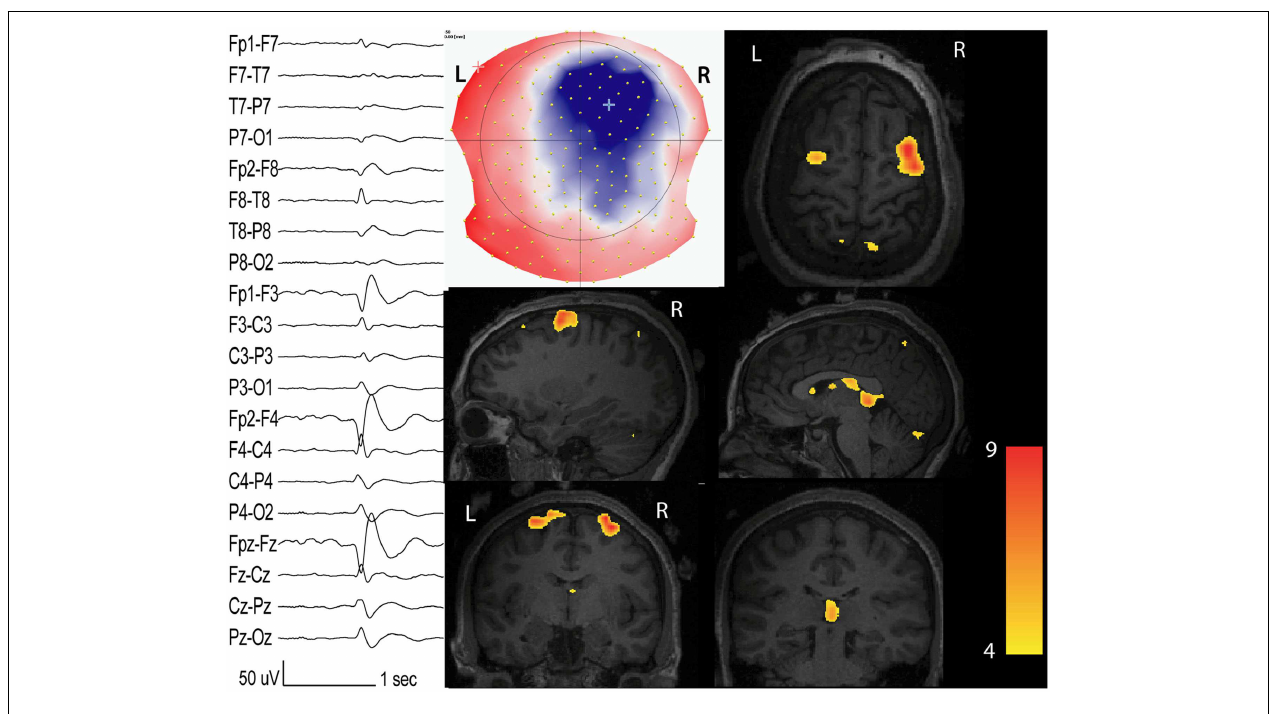
with the maximal right frontal negativity (blue). BOLD response ( t -value = 4; p < 0.05 corrected for family-wise-error) has maximal activation in the spike topography but other clusters with inferior statistical values are present in the contra-lateral homologous region and in the thalamus.